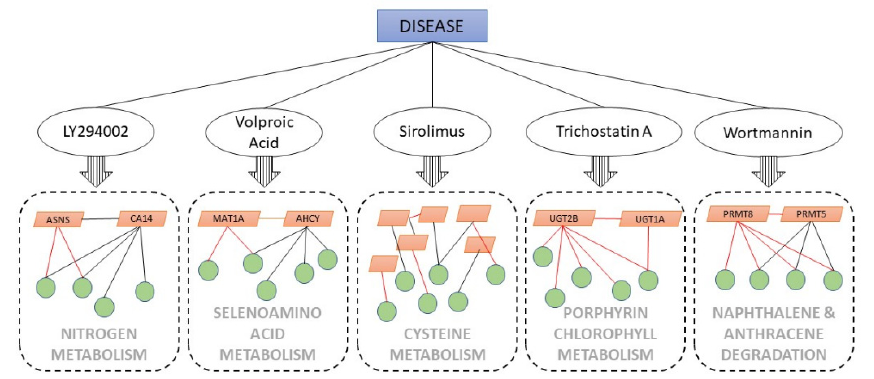
Figure 7. Potential systemic interactions via pathways, which imply systemic drug influence. The red and black lines represent inhibition and activation, respectively. red and black lines represent inhibition and activation,